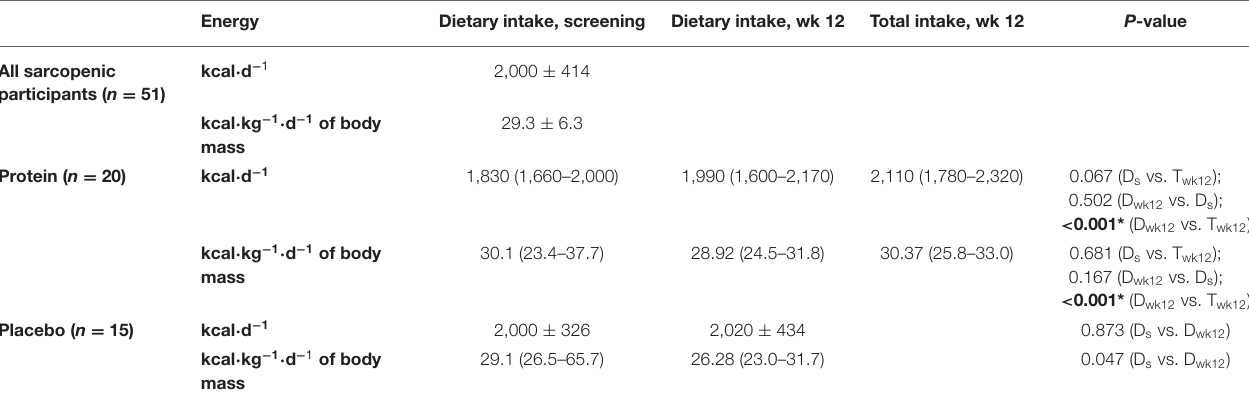
TABLE 2 | Energy intake (median and IQR) based on the 4-day EDR of subgroup of community-dwelling (pre)sarcopenic older adults receiving protein supplement ( n = 20) or placebo supplement ( n = 15). Energy Dietary intake, screening